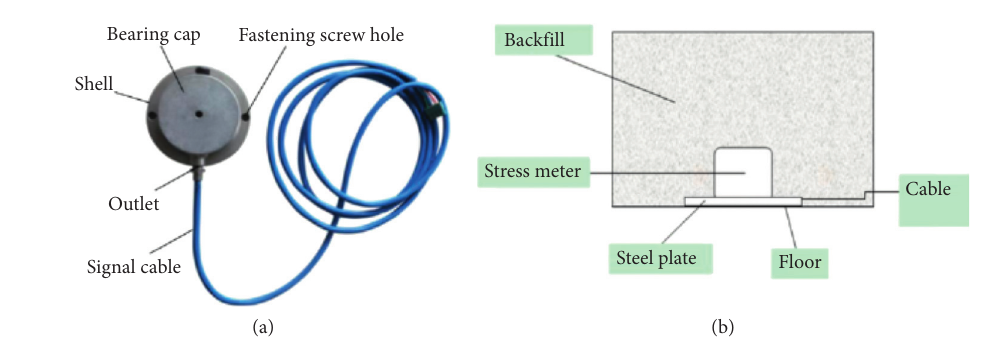
Figure 9: (a) Stress meters and (b) installation